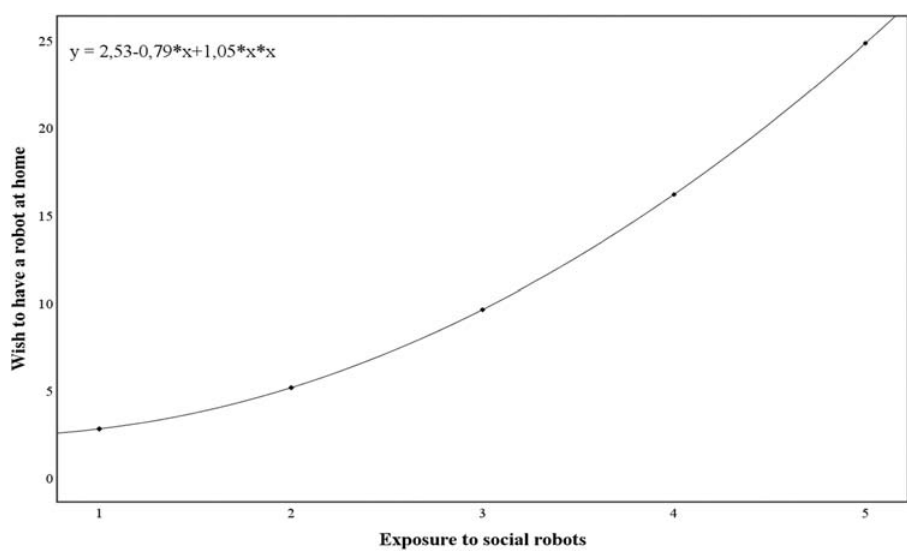
Figure 1: Wish to have a robot at home explained by Exposure to social robots.